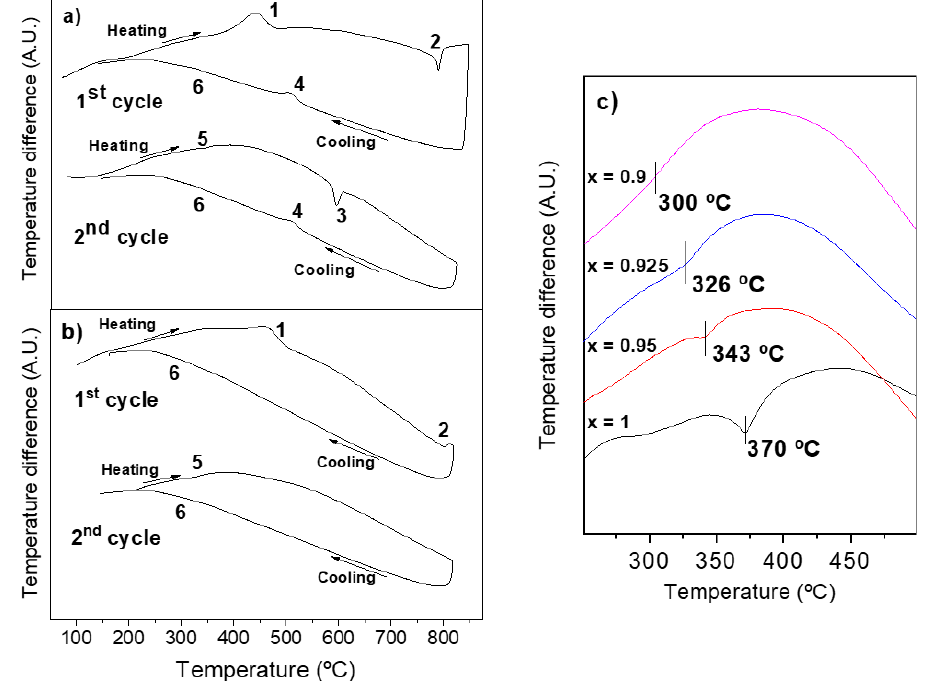
Figure 8. DTA curves of as-mechanosynthesized (1 − x)YMnO 3 –xBiFeO 3 powders during two successive heating-cooling cycles: ( a ) x = 0.95, and ( b ) x = 0.925. Main thermal effects are labelled as 1–6. ( c ) Evolution of effect 5 during the second cycle on heating for compositions with 0.9 ≤ x ≤ 1.